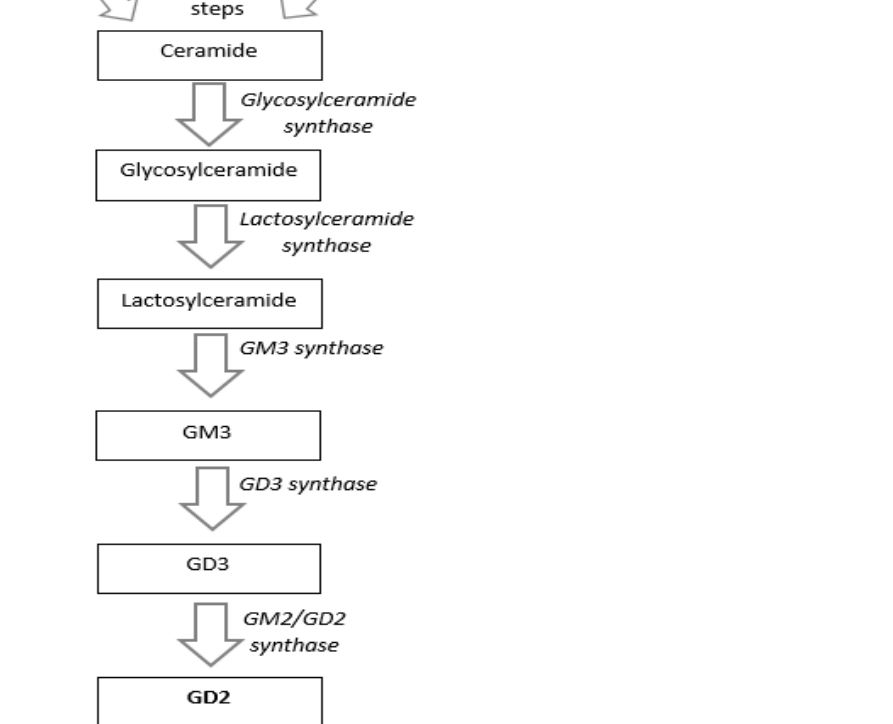
Figure 1. GD2 is a disialoganglioside obtained from ceramides via glycosylations. Ceramides are synthetized from serine and palmitoyl-CoA after various steps. The first glycosylation produces glycosylceramide, which is glycosylated in lactosylceramide. This is converted to GM3 by GM3 synthase, GM3 to GD3, and GD3 to GD2 by GM2/GD2 synthase. GD2 seems to contribute to the binding of tumor cells to the extracellular matrix Gangliosides have an important role in signal transduction as well as cell adhesion and recognition [25]. They are distinguished in a-series, generally expressed in normal tissue, and b-series. In normal tissue, b-series gangliosides are normally expressed during fetal development on neural and mesenchymal stem cells; in adults, they are restricted cytes [26]. GD2 is a b-series ganglioside highly expressed on neuroectoderm-derived tu-